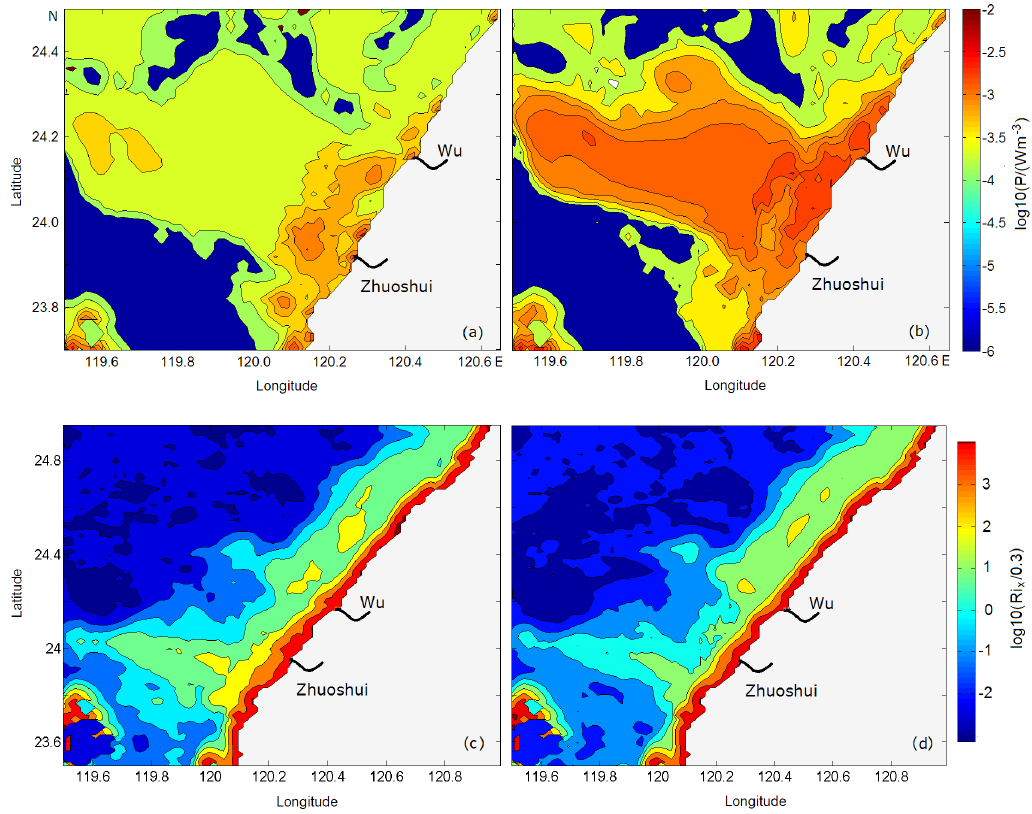
Figure 8. Modelled horizontal distributions of shear production rate of TKE, P S (upper panel) and normalized horizontal Richardson number, Ri X /Ri crit (lower panel) at 1m depth at (a, c) 08:00 and (b, d) 11:00 GMT on 27 June